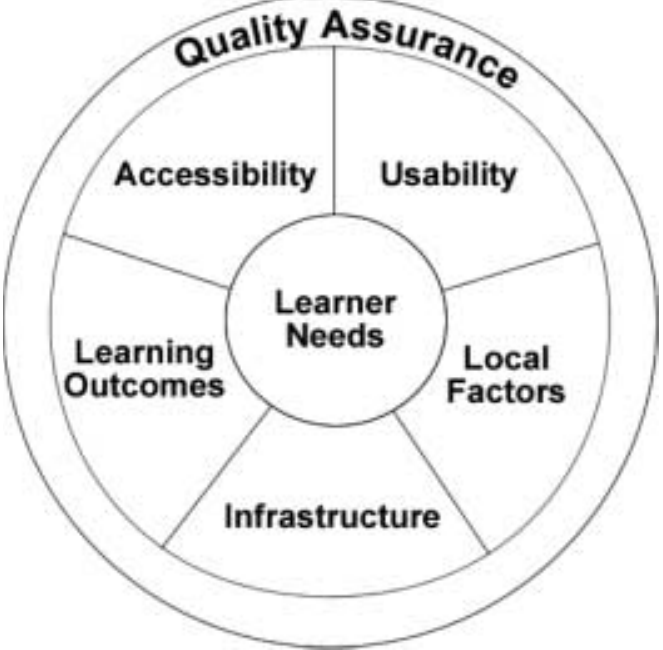
Figure 1. A holistic framework for e-learning